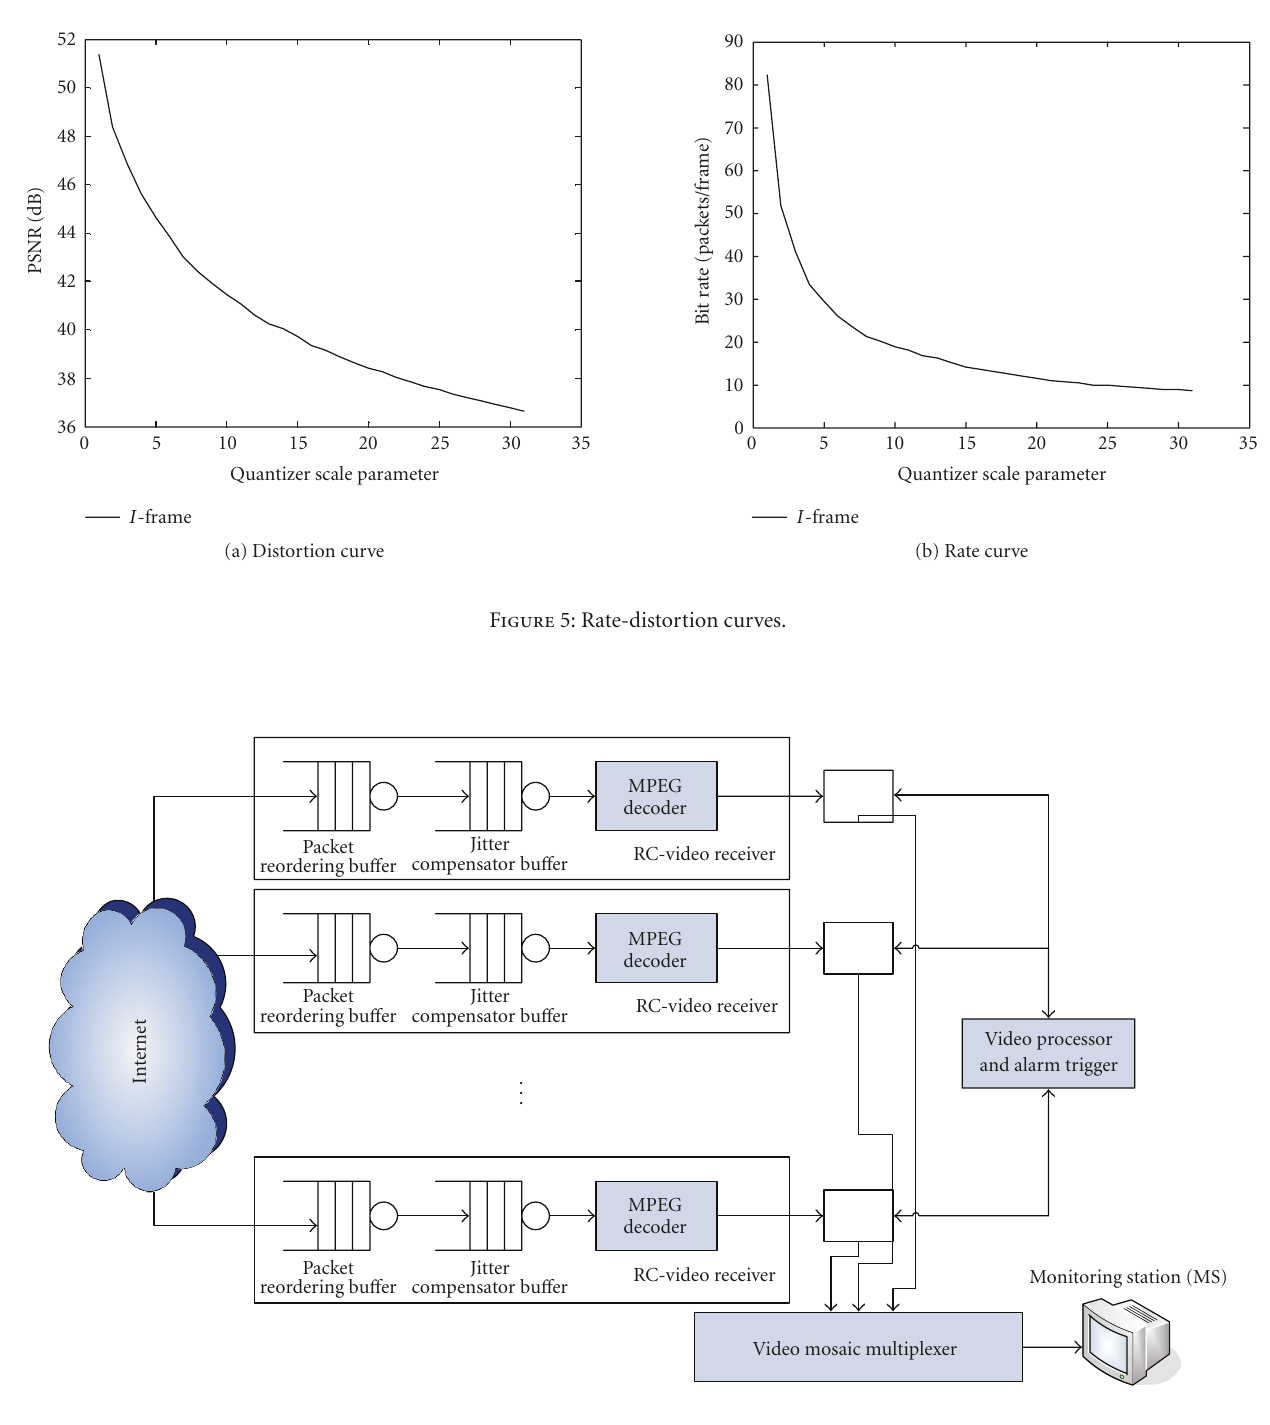
Figure 6: Processing proxy server